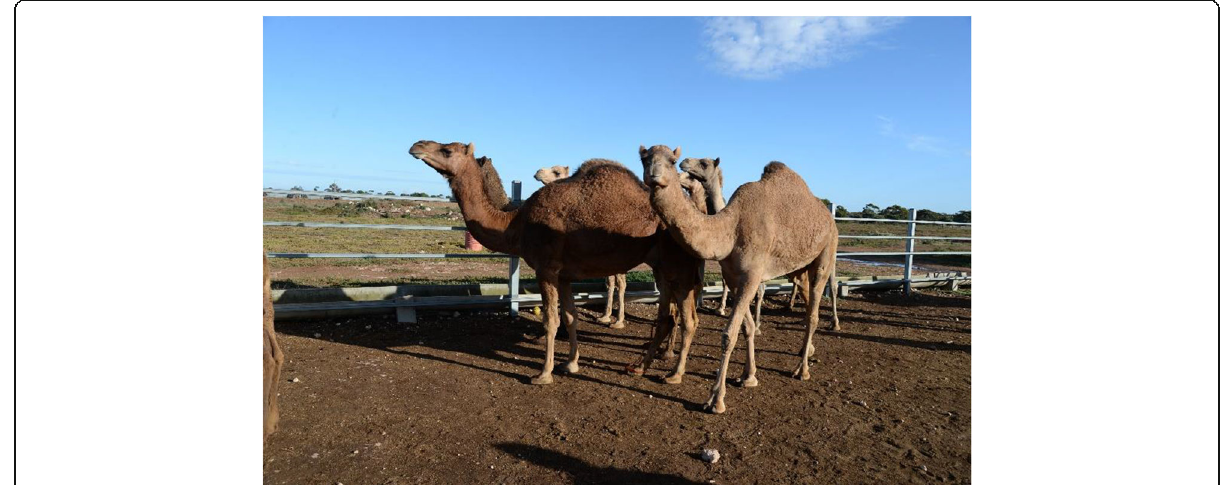
Fig. 13 Camel farm for meat and milk production, region of Adelaide, Australia (Ph. B.